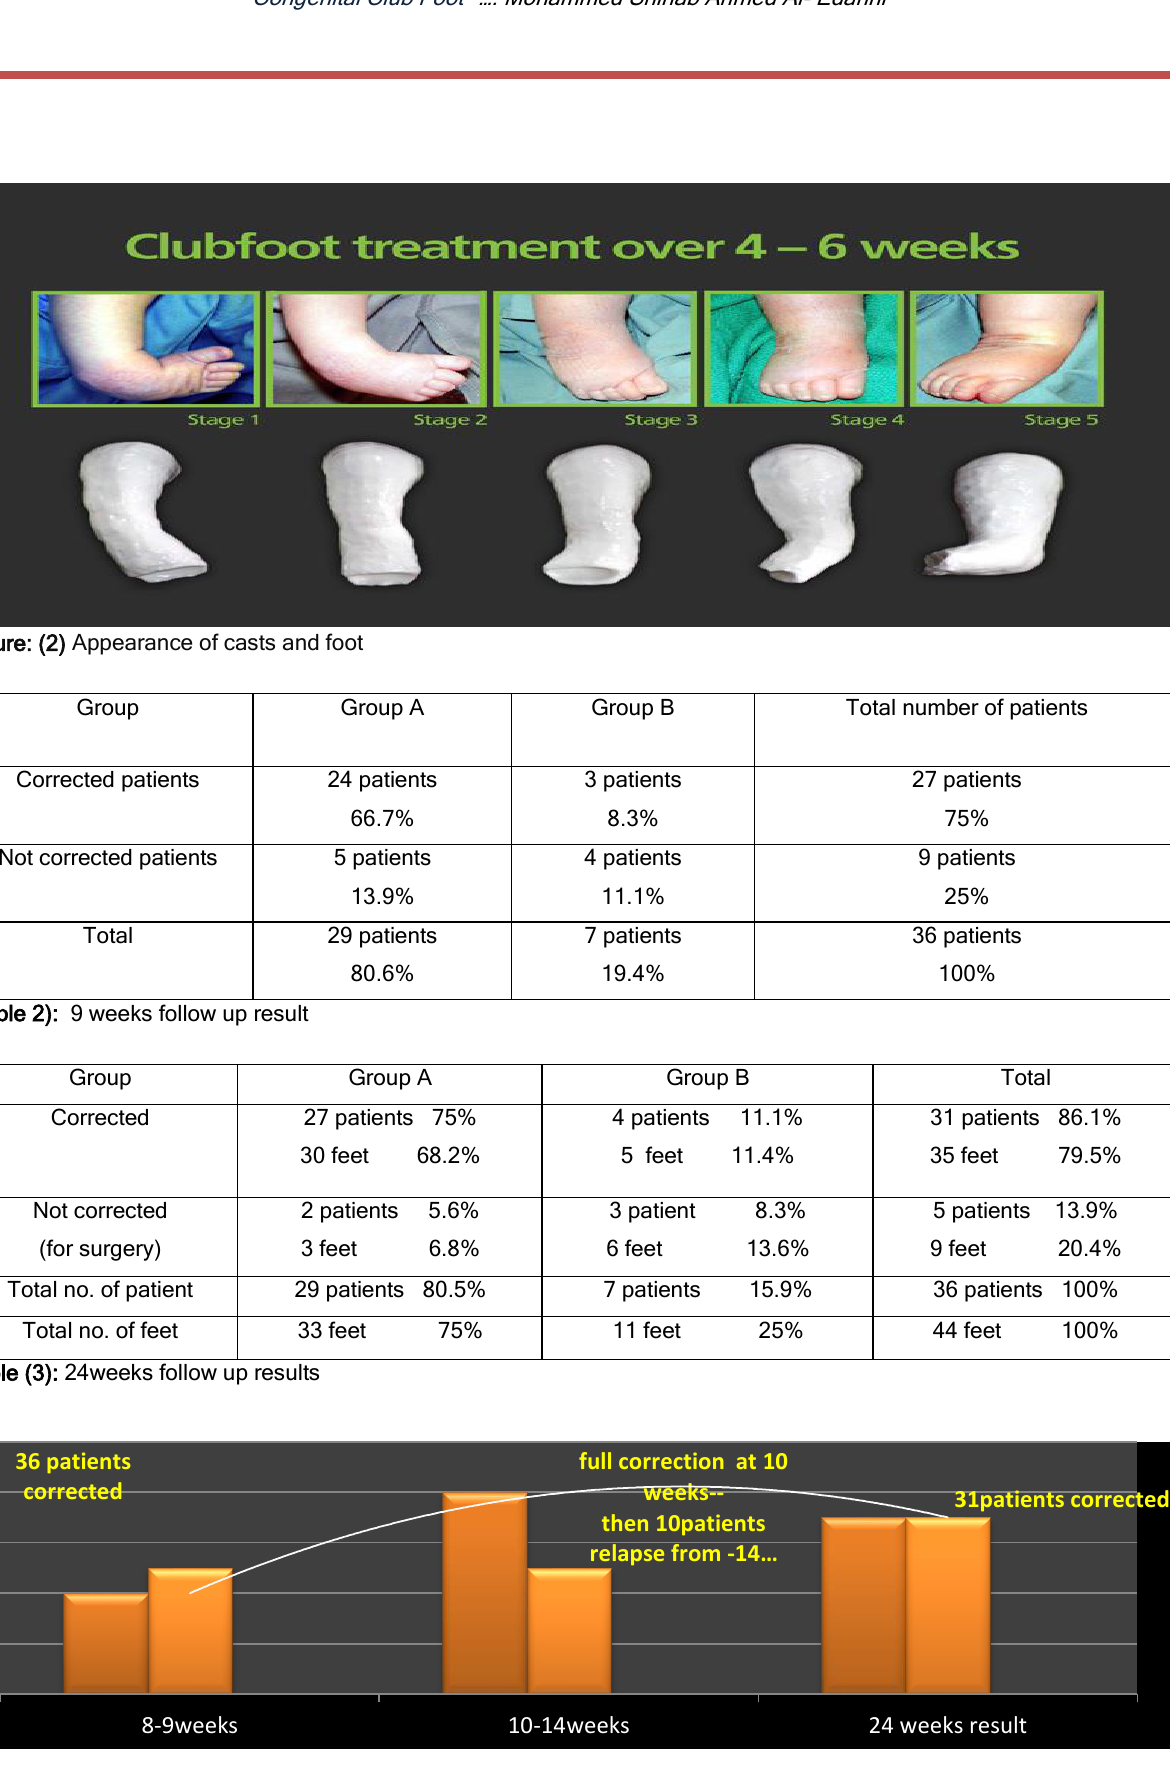
Fig. 3 : Pattern of response to the treatment from the beginning to management